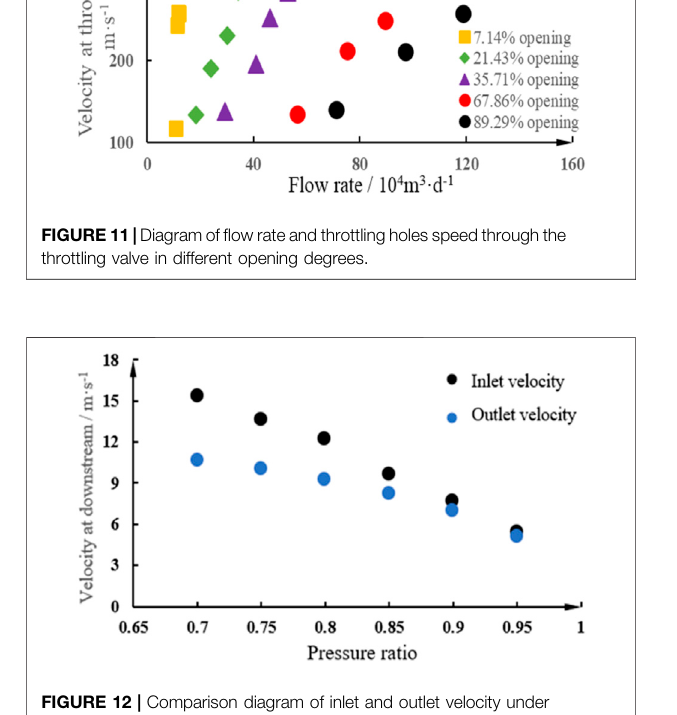
FIGURE 12 | Comparison diagram of inlet and outlet velocity under different pressure ratios at an opening degree of 89.29%.